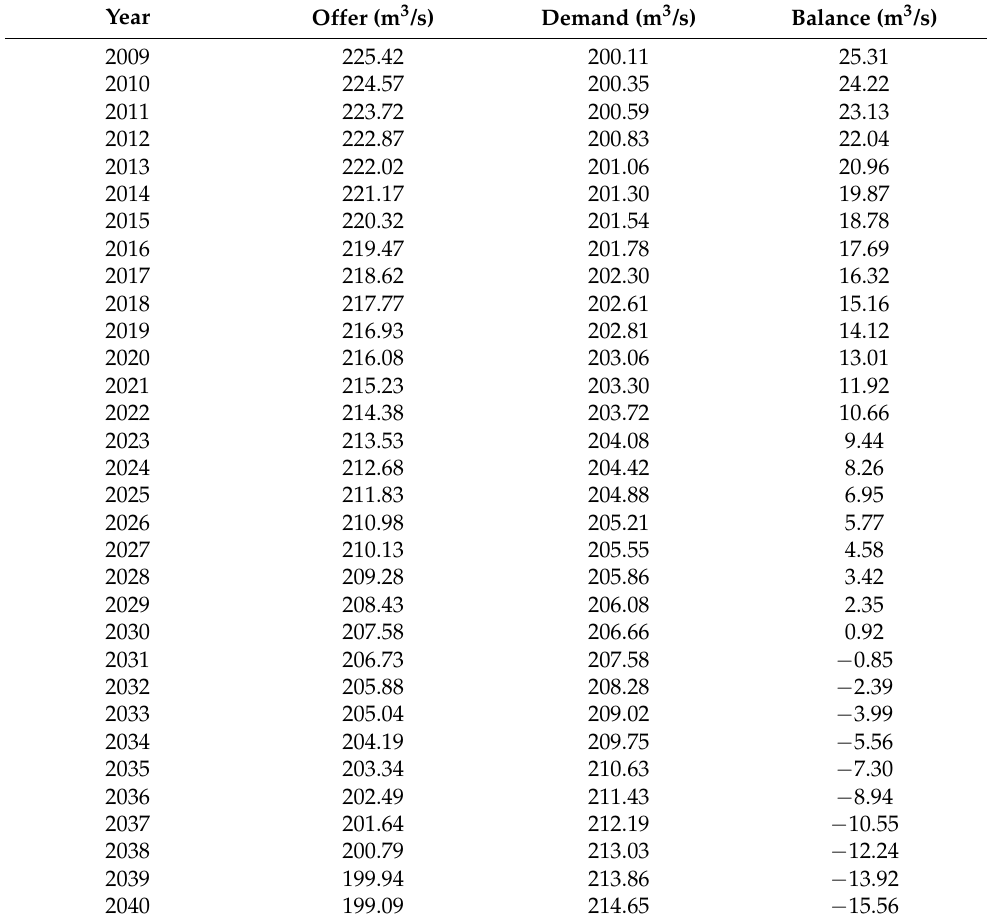
Table 2. Contrasting offer and demand (2009–2040) for the Libertador Bernardo O’Higgins Region (forecast was performed based on data from the Chilean Ministry of Environment, the Chilean Ministry of Public Works, and